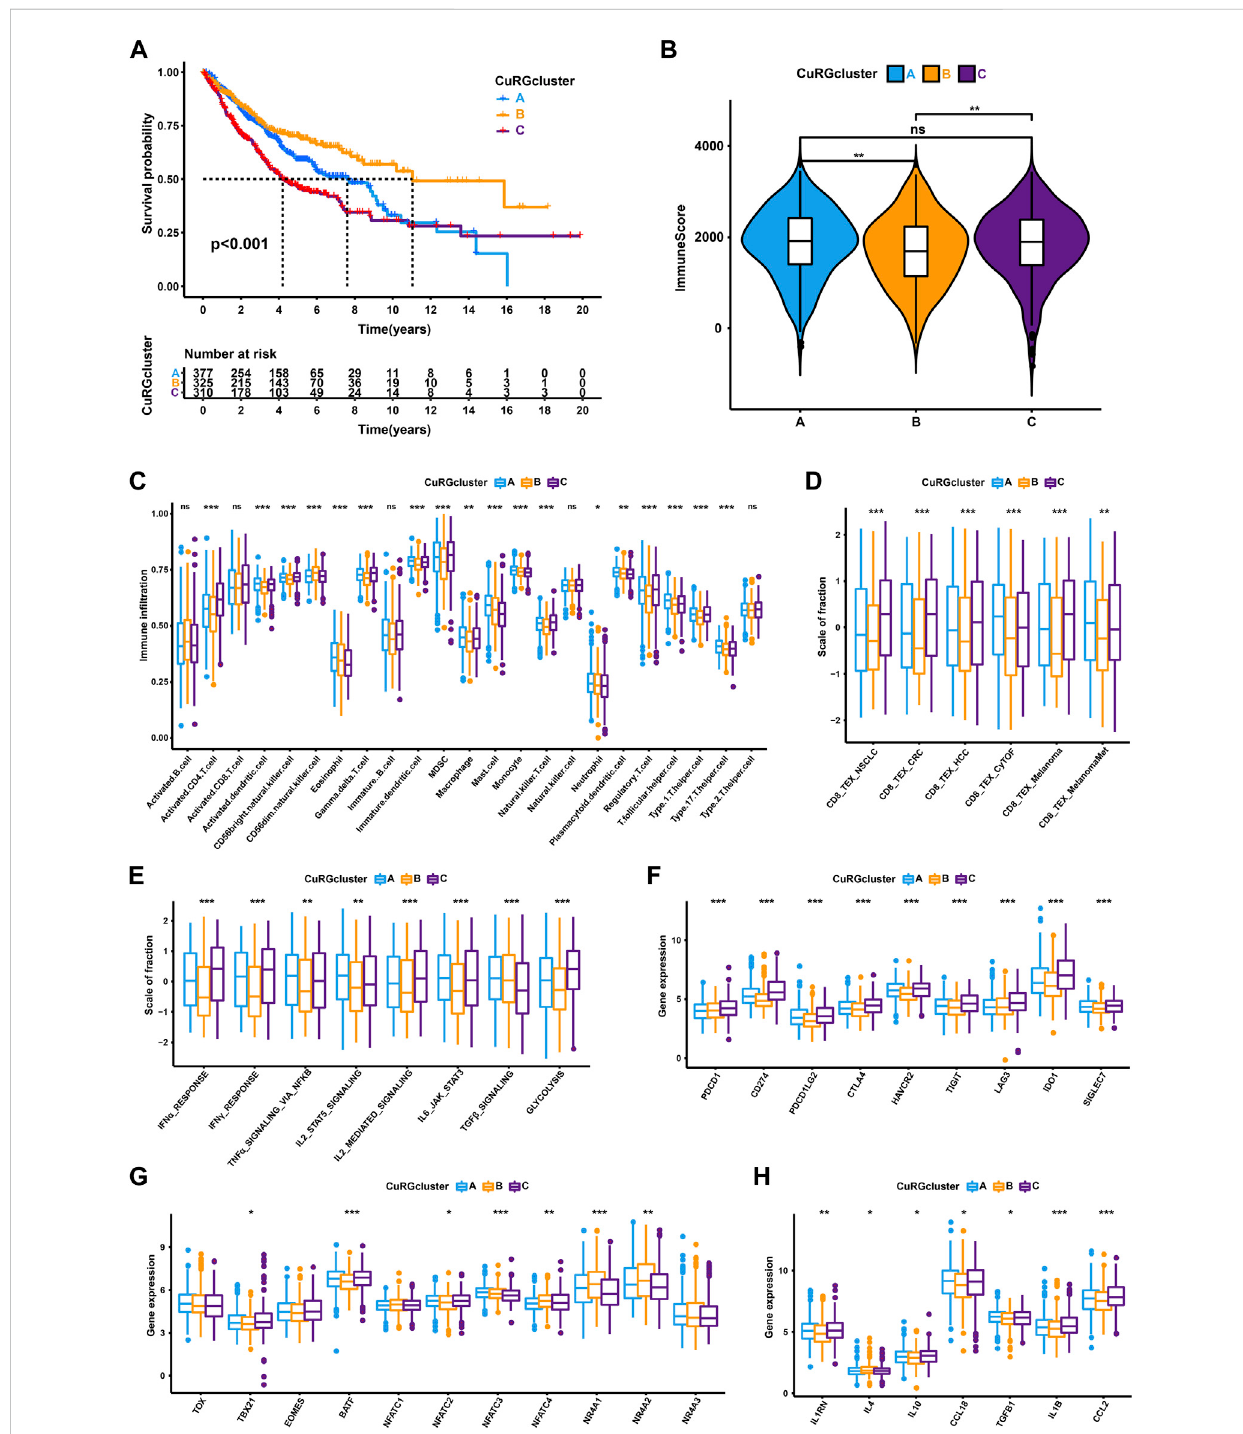
FIGURE 2 TEX and TIME characteristics of each CuRGcluster. (A) Survival analyses for the three CuRGclusters based on 1012 patients from the training cohort (GSE30219, GSE31210, GSE37745, GSE50081, TCGA-LUAD). (B) Immune score analyses using the ESTIMATE algorithm in three CuRGclusters. (C) The abundance of each tumor microenvironment in fi ltrating cell in CuRGcluster A-C. (D – H) GSVA enrichment analysis between CuRGcluster A-C with TEX- related signatures (D) , signal pathways (E) , immune checkpoint genes (F) , transcription factors (G) , or in fl ammatory factors (H) . The line in the box represents the median value, and the asterisk represents the p -value. * p < 0.05; ** p < 0.01; *** p <